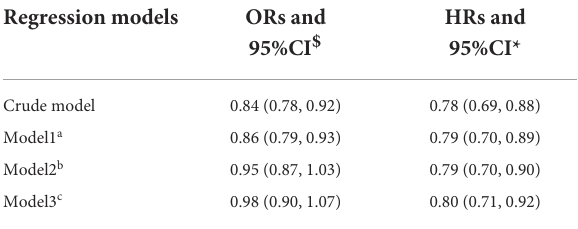
TABLE 2 Association between tap-water use and CGD.